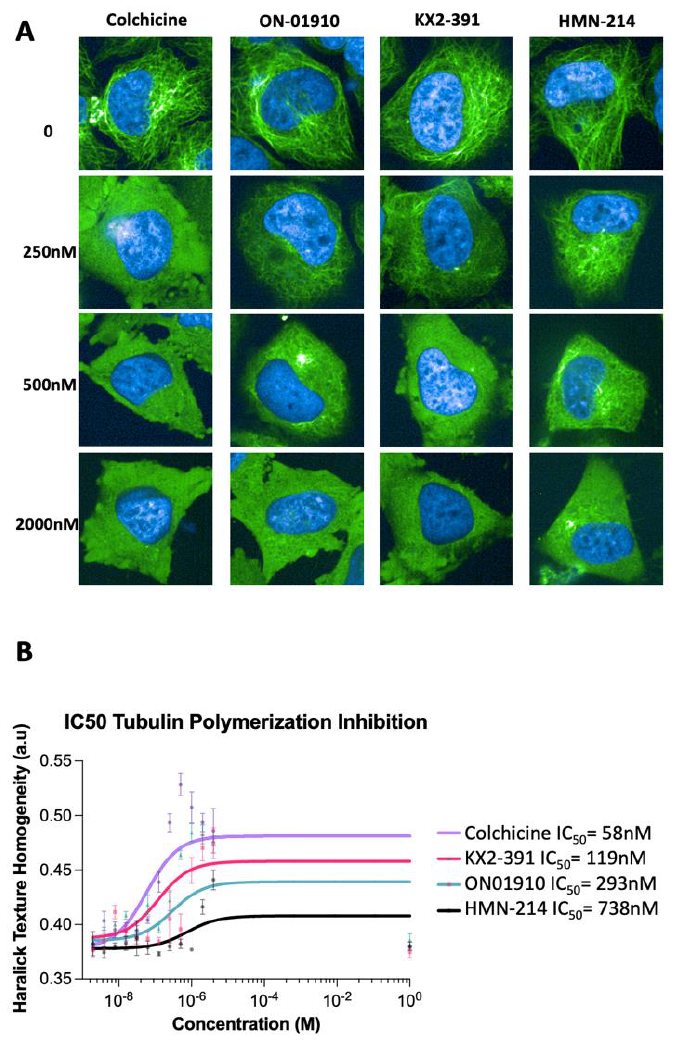
Figure 3. Validation of ON-01910, KX2-391, and HMN-214 as tubulin polymerization inhibitors. ( A ) Representative images of cells treated with three kinase inhibitors identified as potential tubulin polymerization inhibitors. The cells were treated in triplicates in a range of concentrations between 1 nM and 4000 nM. ( B ) The Haralick texture homogeneity values of cells treated with the three compounds (1 nM to 4000 nM) was used to determine the phenotypic half maximal tubulin polymerization inhibitory concentration (IC 50 ). Each data point is n = 3; these data are representative of three independent experiments.